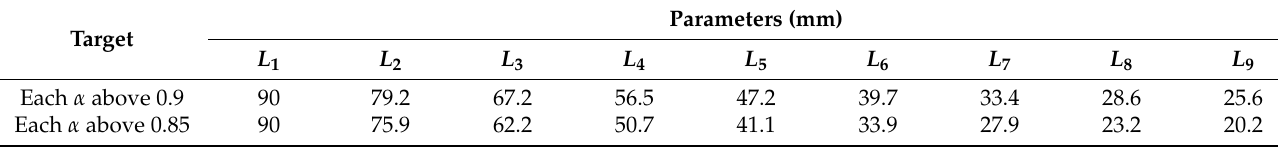
Table 5. The summary of the optimized length of the cavity for each chamber in the desired APH- AM